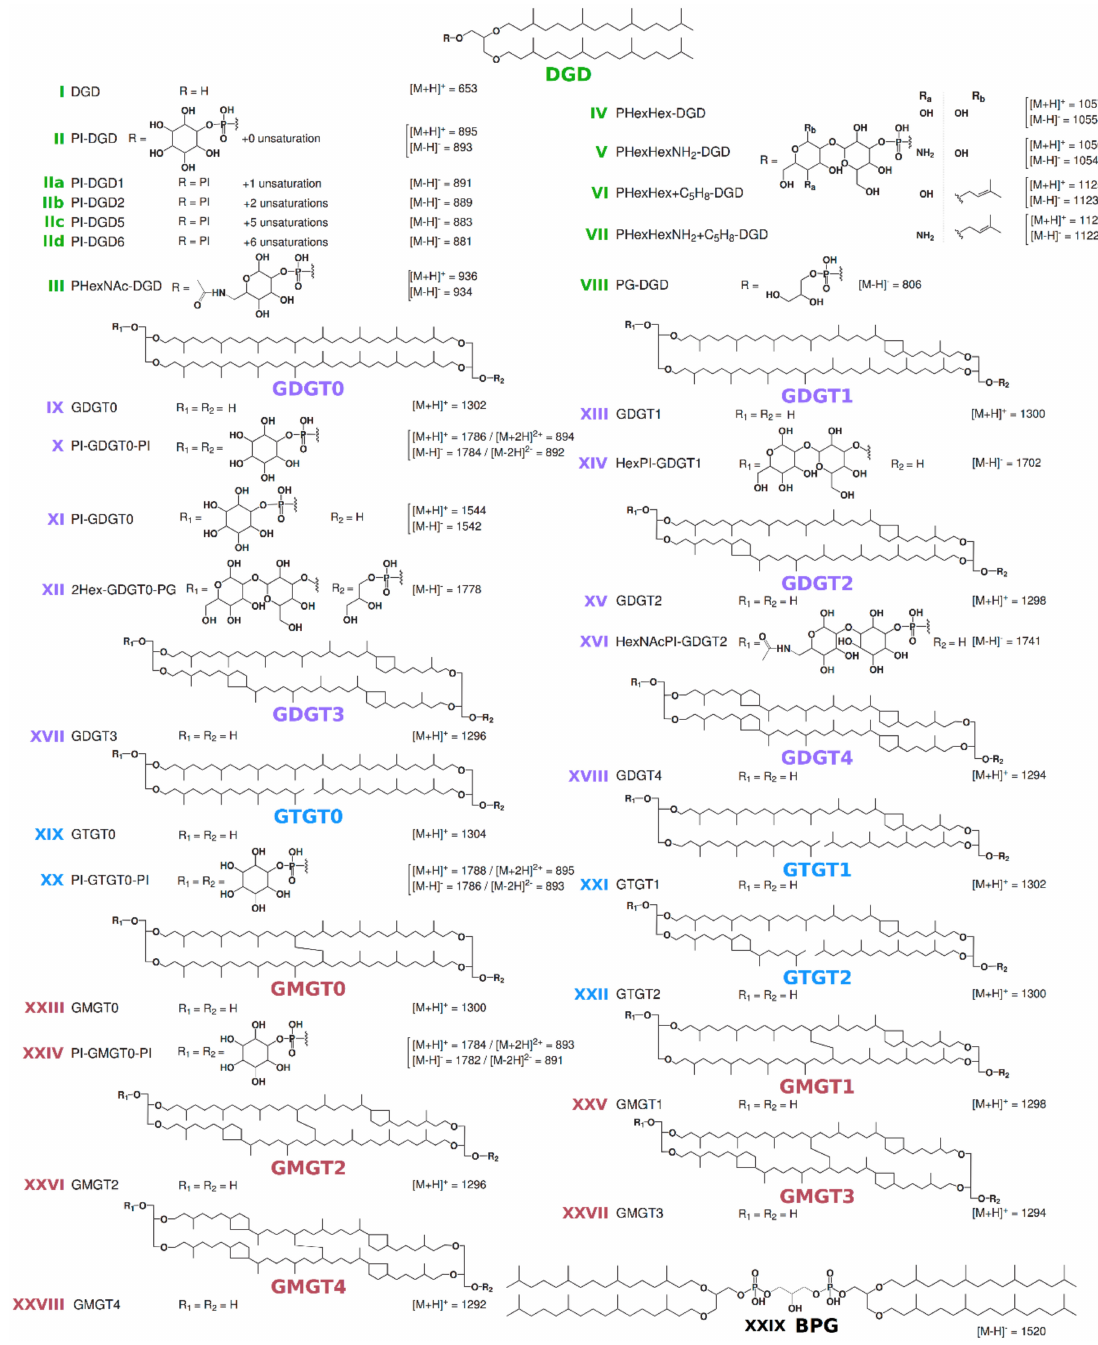
Figure 1. Core and intact polar lipids identified in Pyrococcus furiosus , Pyrococcus yayanosii and Thermococcus kodakarensis and other lipids mentioned in the text. Shorthand nomenclature is indicated. The protonated and / or deprotonated mass–charge ratios are indicated for each structure when detected. Ammoniated and sodiated adducts were also detected and used for integration, but are not represented here. Core structures: dialkyl glycerol diethers (DGD; green) with 0 ( I , II , III , IV , V , VI , VII and VIII ) and with 1 ( IIa ), 2 ( IIb ), 5 ( IIc ) and 6 ( IId ) unsaturations; glycerol dialkyl glycerol tetraethers (GDGT; purple) with 0 ( IX , X , XI and XII ) and with 1 ( XIII and XIV ), 2 ( XV and XVI ), 3 ( XVII ) and 4 cyclopentane rings ( XVIII ); glycerol trialkyl glycerol tetraethers (GTGT; blue) with 0 ( XIX and XX ) and with 1 and 2 cyclopentane rings ( XXI and XXII ); glycerol monoalkyl glycerol tetraethers (GMGT, red) with 0 ( XXIII and XXIV ) and with 1 to 4 cyclopentane rings ( XXV to XXVIII ). Polar head